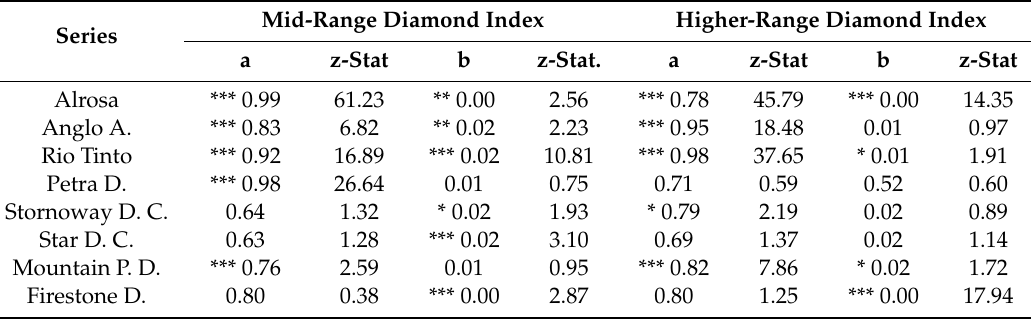
Table 9. DCC parameters from the DCC-EGARCH correlation